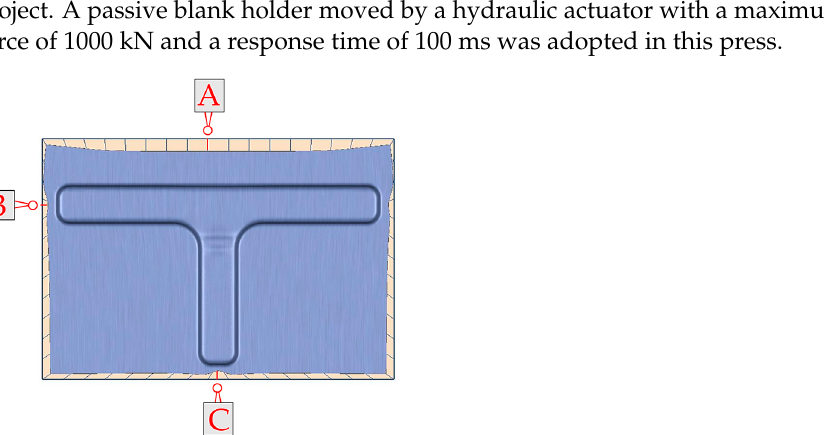
Figure 1. T-shaped component and points where the drw-in was monitored (A, B and C).